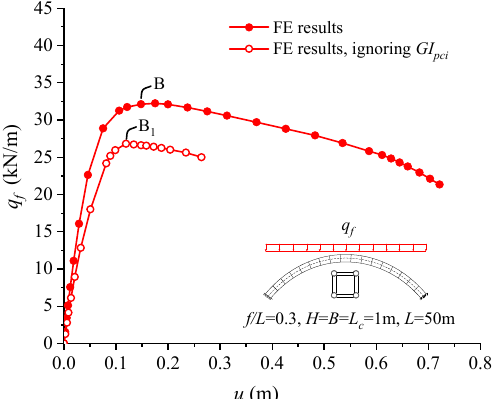
Figure 15. Out-of-plane vault displacements of the typical Vierendeel truss arch under FSUVLs.